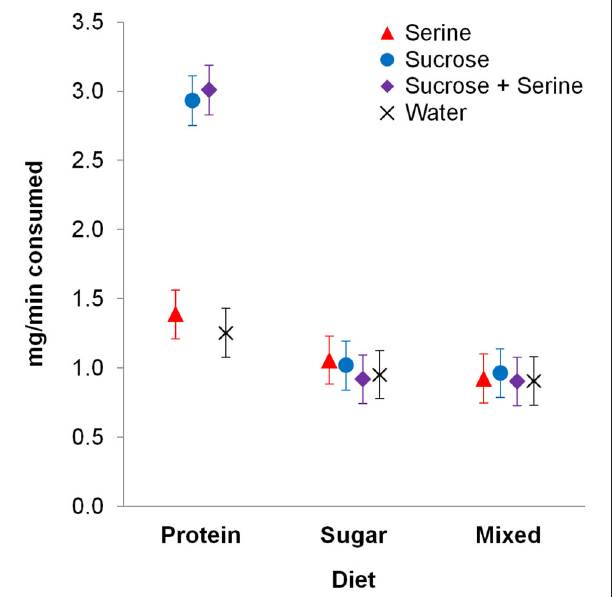
FIGURE 1 | Consumption of test solutions (serine, sucrose, sucrose + serine, water) by workers from colony fragments maintained on different diets. Estimated means and standard error bars are given. Continuous predictors are fixed at the following mean values: 0.765mg/min of consumed test solution during pre-restriction tests; 13.6 days after